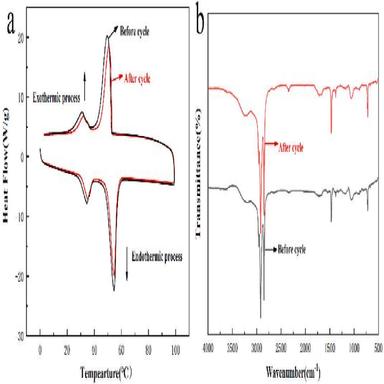
DSC curves (a) and FT–IR spectra (b) of PCC1100. before and after 200 thermal cycles.